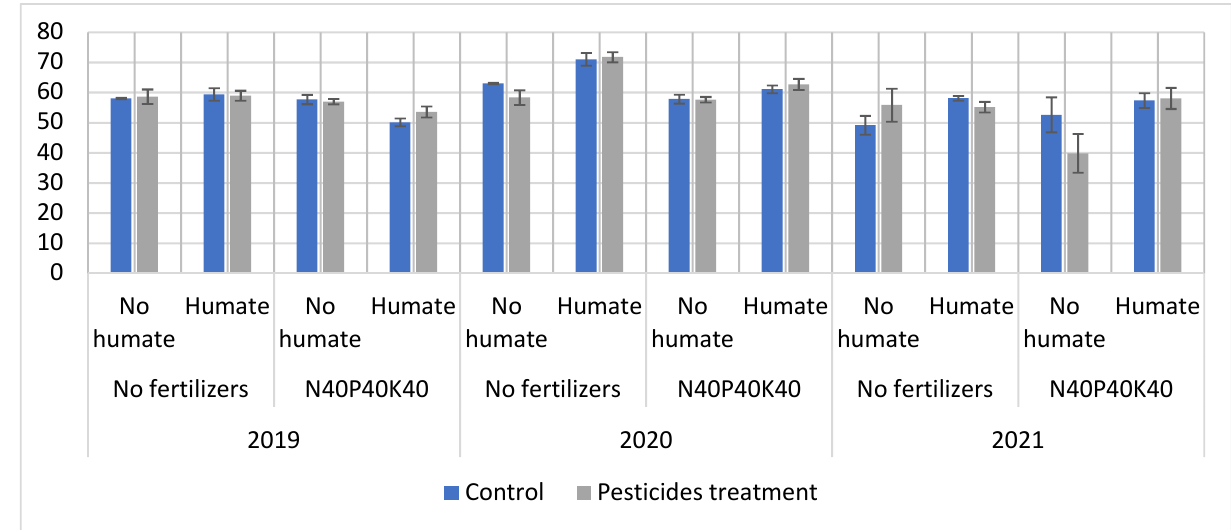
Figure 2. Dynamics of the distribution of water-resistant soil aggregates (%) in Calcic Chernozem under chickpea with the application of mineral fertilizers and a humic preparation on experimental variants with and without pesticides.